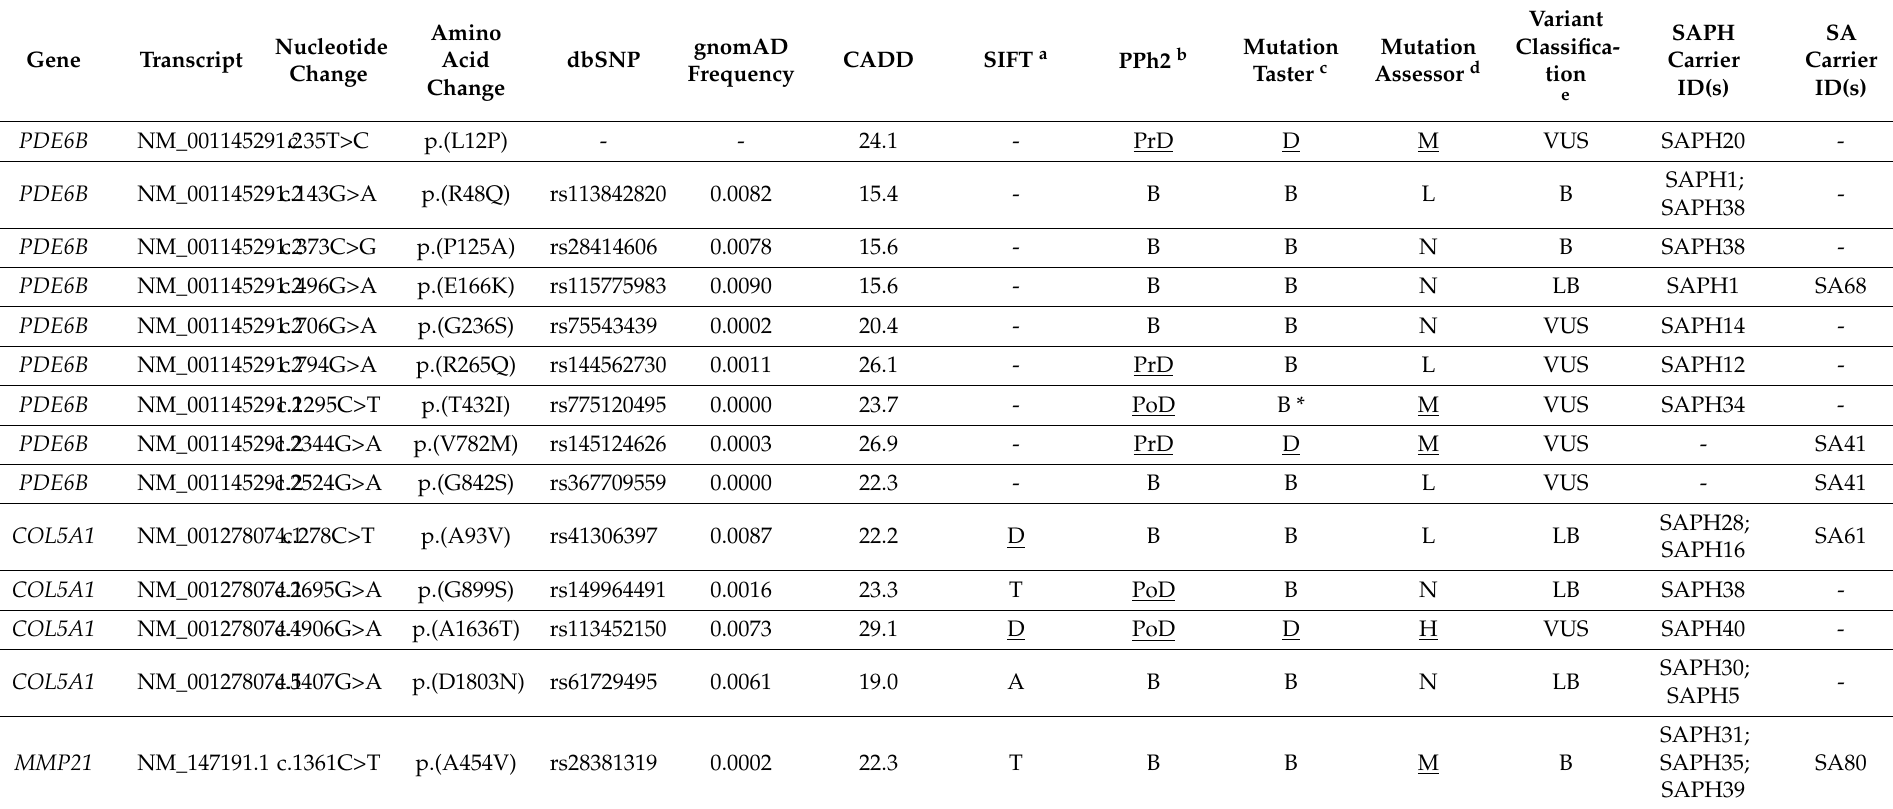
Table 3. Rare variants found in the exploratory case-control analysis in 572 genes biologically involved in PH pathogenesis. Genes biologically involved in PH pathways in which ≥ 15% of the SAPH patients carry a variant and no more than 5% ( n = 2) of the SA patients do. (a) SIFT: T = Tolerated; D = Damaging; A = Activating; (b) PolyPhen-2: B= Benign; PrD = Probably Damaging; PoD = Possibly Damaging; (c) Mutation Taster: D = Deleterious; B = Benign; (d) Mutation Assessor functional impact: N = Neutral; L = Low; M = Medium; H = High; Predicted functional impact high or medium is predicted functional; low or neutral is predicted non-functional. Predictions by SIFT, PolyPhen-2, Mutation Taster, or Mutation Assessor indicating deleterious consequences are underlined. (e)